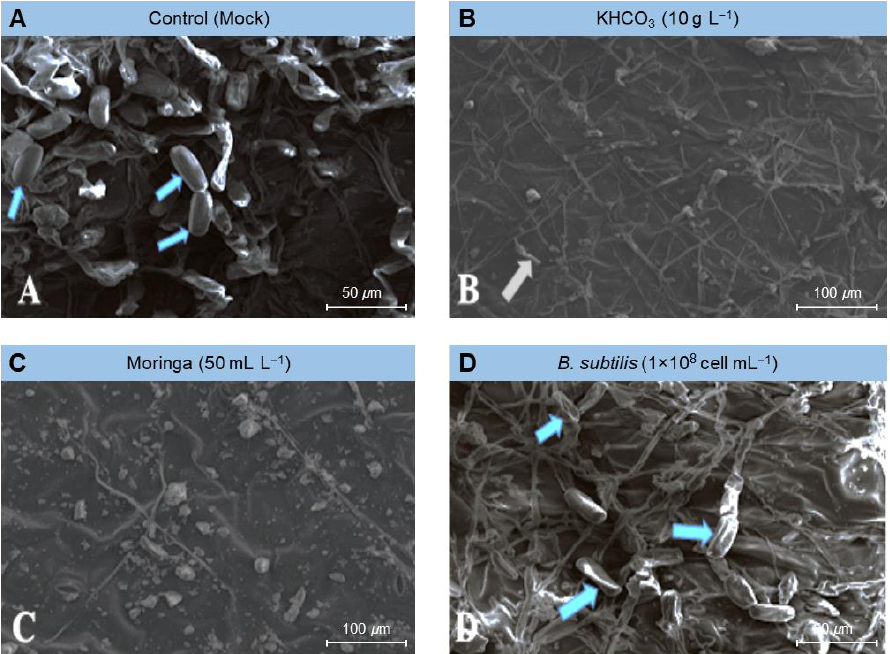
Figure 5. Effect of the most promising treatments on the morphology and number of conidia formed by Erysiphe betae , the causal agent of powdery mildew on sugar beet using scanning electron microscopy (SEM). ( A ) mock-treated plants (tap water), ( B ) plants treated with 10 g L −1 potassium bicarbonate, ( C ) plants treated with 50 mL L −1 Moringa seeds extract, and ( D ) plants treated with a cell suspension of Bacillus subtilis (1 × 10 8 cell mL −1 ).